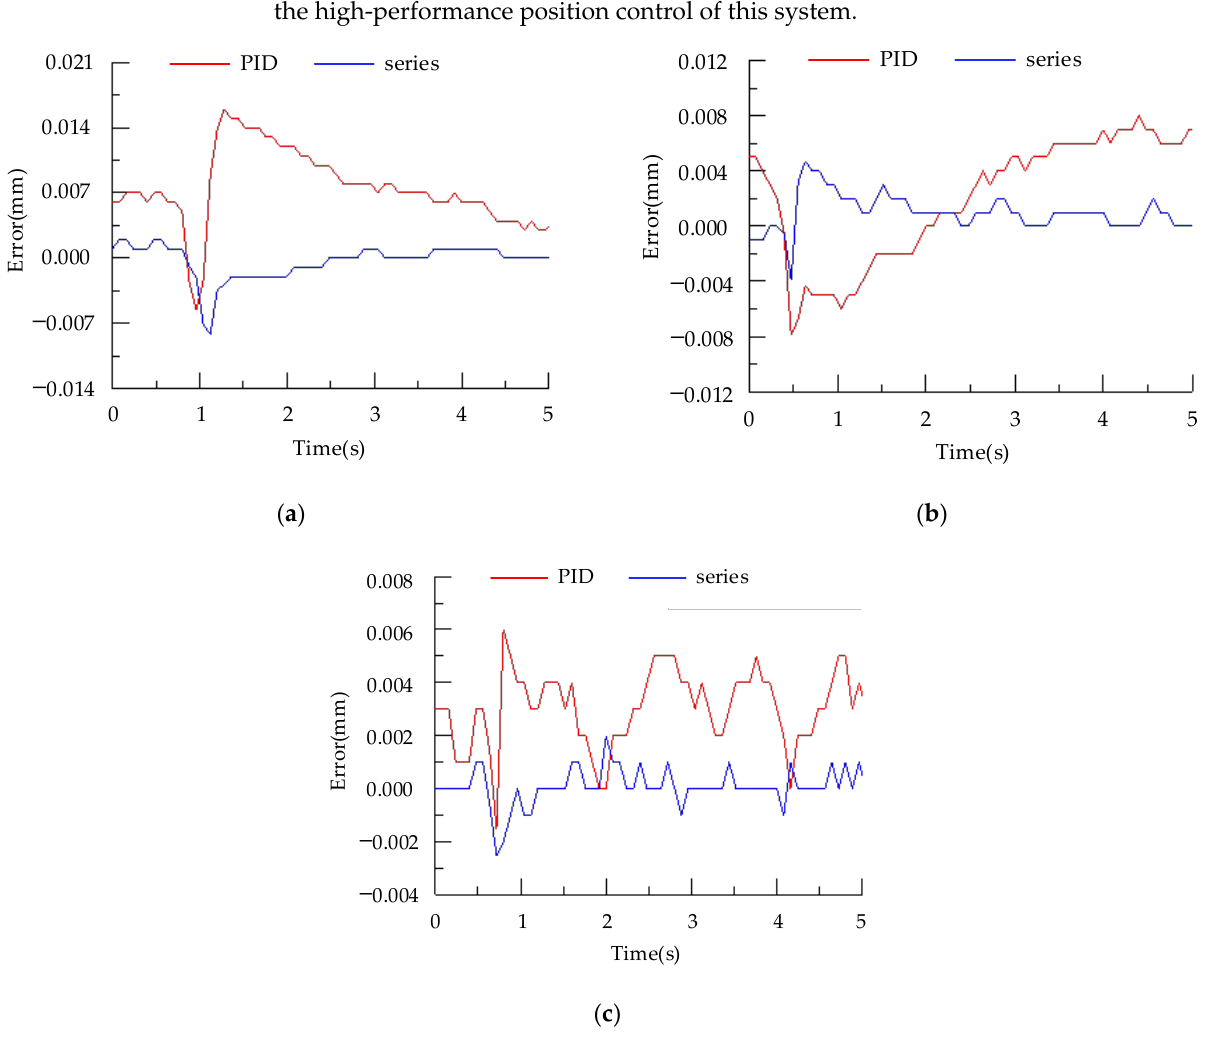
Figure 11. Displacement tracking curve. ( a ) Displacement 0.1 mm; ( b ) displacement 0.05 mm; ( c ) displacement 0.01 mm.